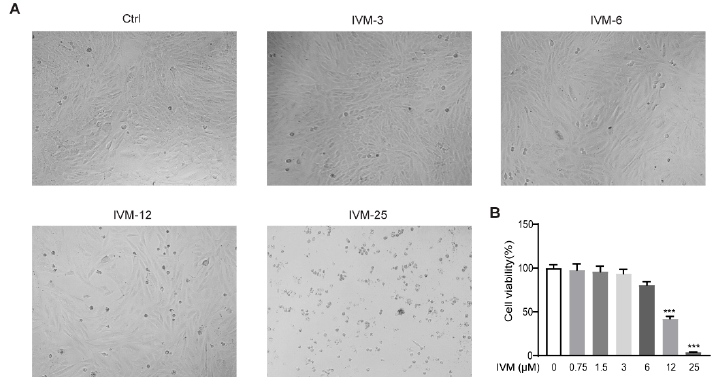
Figure 6. Impacts of ivermectin on cell viability in CFSC cells: ( A ) bright-field images of CFSC cells; ( B ) cell viability of CFSC cells assessed using a cell counting kit-8 (CCK-8) assay. Data are expressed as means ± SEM ( n = 3). Note: *** p < 0.001.